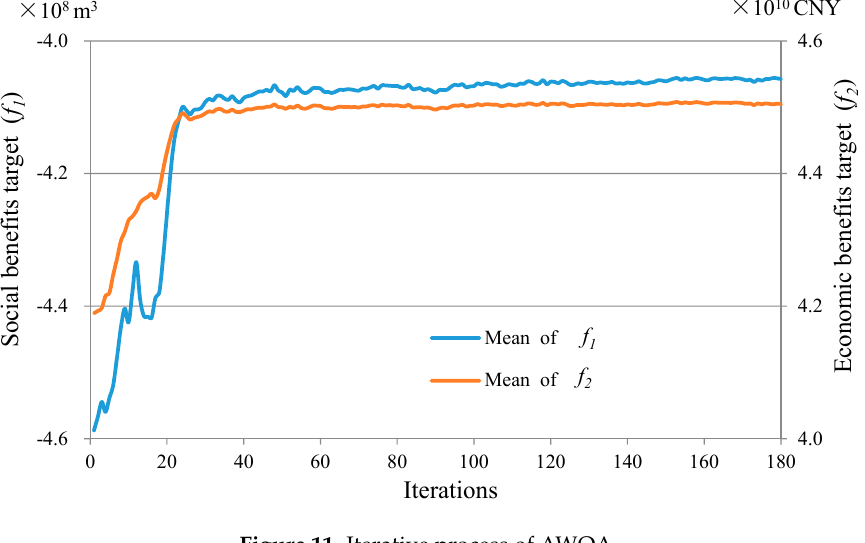
Figure 11. Iterative process of AWOA.